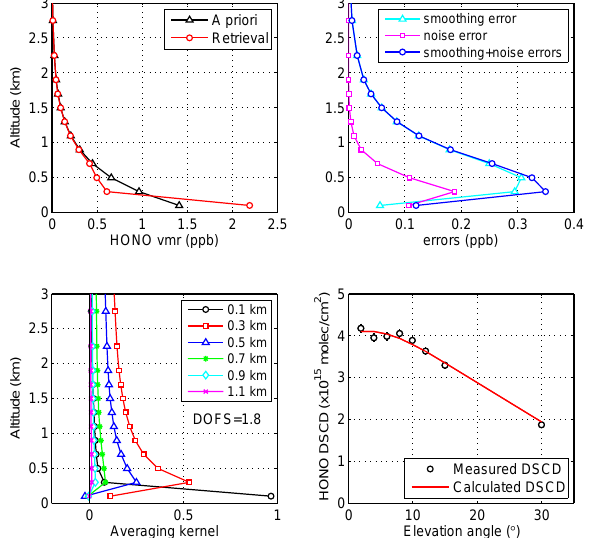
Fig. 3. Same as Fig. 2 but for NO 2 .